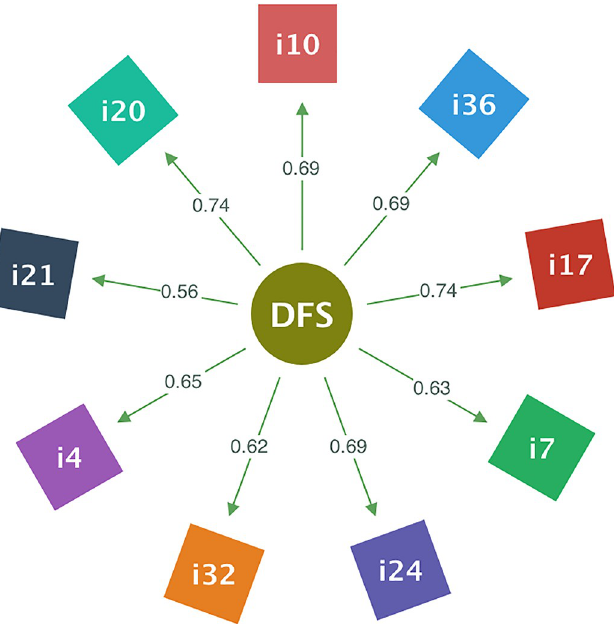
Fig 2. Item loadings in the unimodel of the DFS-Short